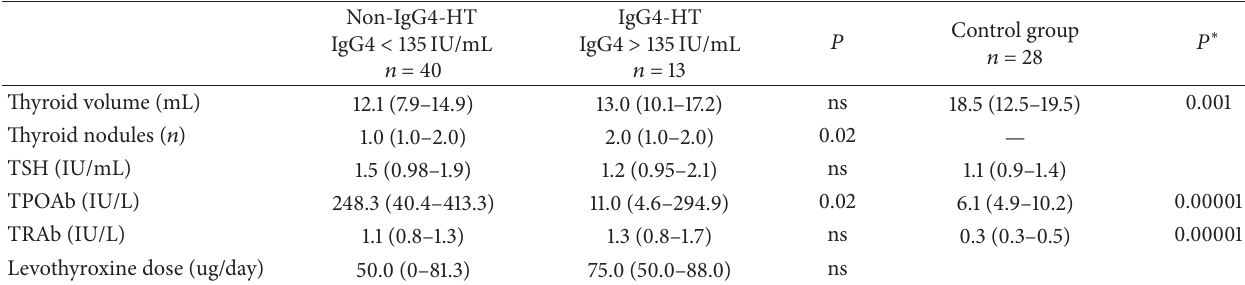
Table 1: Ultrasonographic and biochemical characteristics of the patients with non-IgG4-HT, IgG4-HT, and the control group.